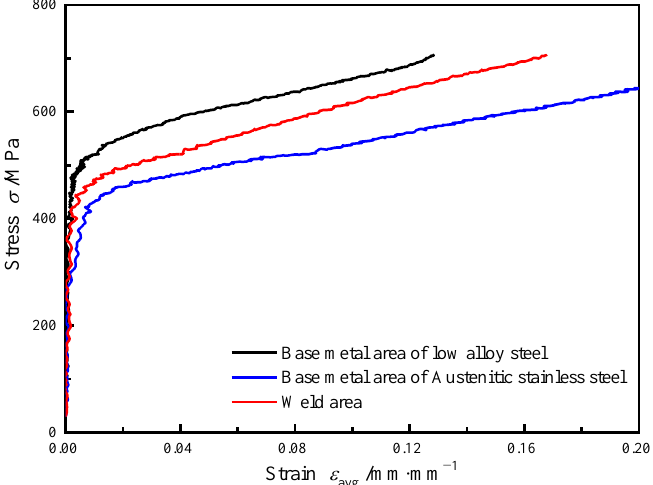
Figure 18. Relationship curve between stress and average strain in each region of interest.